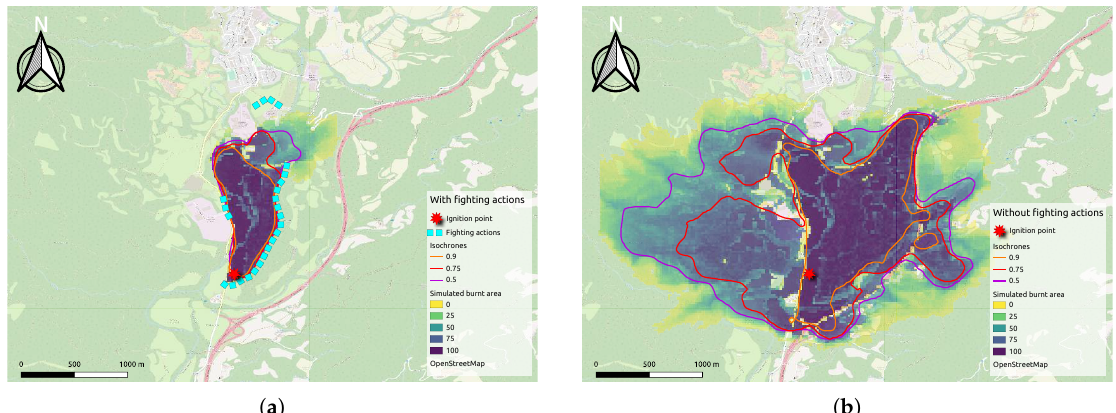
Figure 12. Comparison between the results obtained implementing the fighting action ( a ) and without this implementation ( b ) for the Avinyo test case. The ignition point is represented with a red star, while the fighting actions are in light blue dashed line; the simulated burnt areas are shown both representing the probability of being burnt (colored scale) and the isochrones that represent the burnt area with a probability higher than 50%, 75%, and 90% after 12 h of simulation.